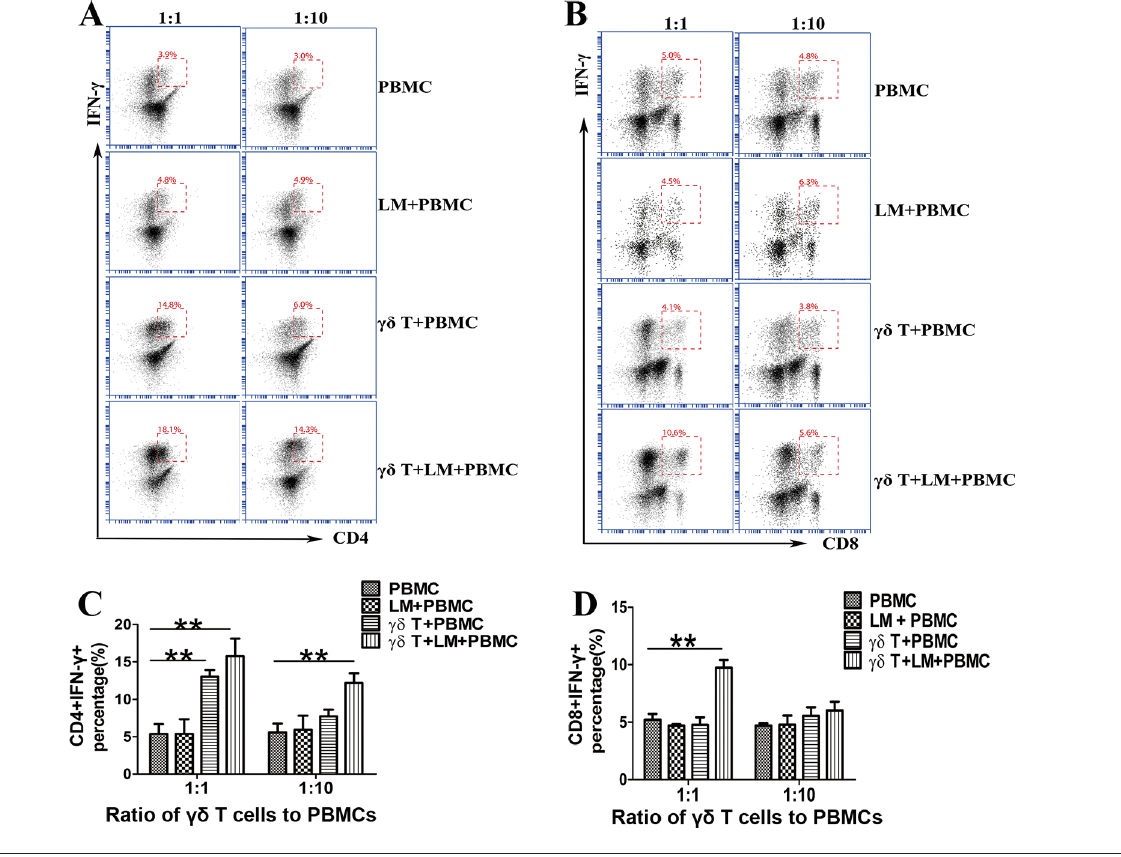
Figure 6. The differentiation of CD4 + and CD8 + T cells were induced by γδ T cells which phagocytosed L. monocytogenes . FCM analysis of intracellular IFN- γ expression in (A) CD4 + T cells and (B) CD8 + T cells after stimulation with PMA + Ion for two hours and blockage with BFA for four hours. After phagocytized L. monocytogenes , γδ T cells induced CD4 + T cells and CD8 + T cells to express IFN- γ at a high ratio of γδ T cells to responder cells. (C) Quantitation of the percentages of IFN- γ secreting CD4 + T cells in different treatments. (D) Quantitation of the percentages of IFN- γ secreting CD8 + T cells in different treatments. Data are shown as mean ± SEM from four independent experi- ments. * P < 0.05. ** P <